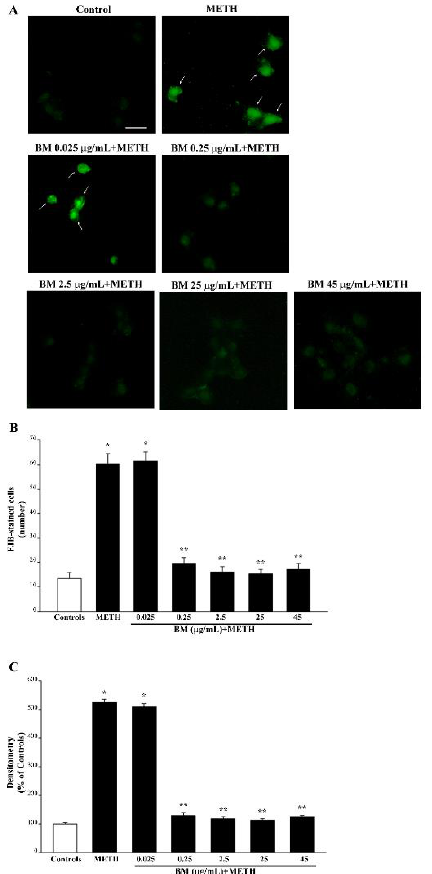
Figure 5. BM decreases METH-induced FJB staining. ( A ) Representative pictures of FJB-stained cells after METH (100 µ M) alone or in combination with various doses of BM (from 0.025 µ g/mL up to 45 µ g/mL). Arrows indicate cells intensely stained with FJB. Graphs report either ( B ) the number or ( C ) the intensity of FJB fluorescent cells. Values are given as mean ± S.E.M. ( B ) or the mean percentage ± S.E.M. (assuming controls as 100%, ( C )) of cells from three independent experiments. * p < 0.05 compared with controls; ** p < 0.05 compared with METH. Scale bar = 12 µ